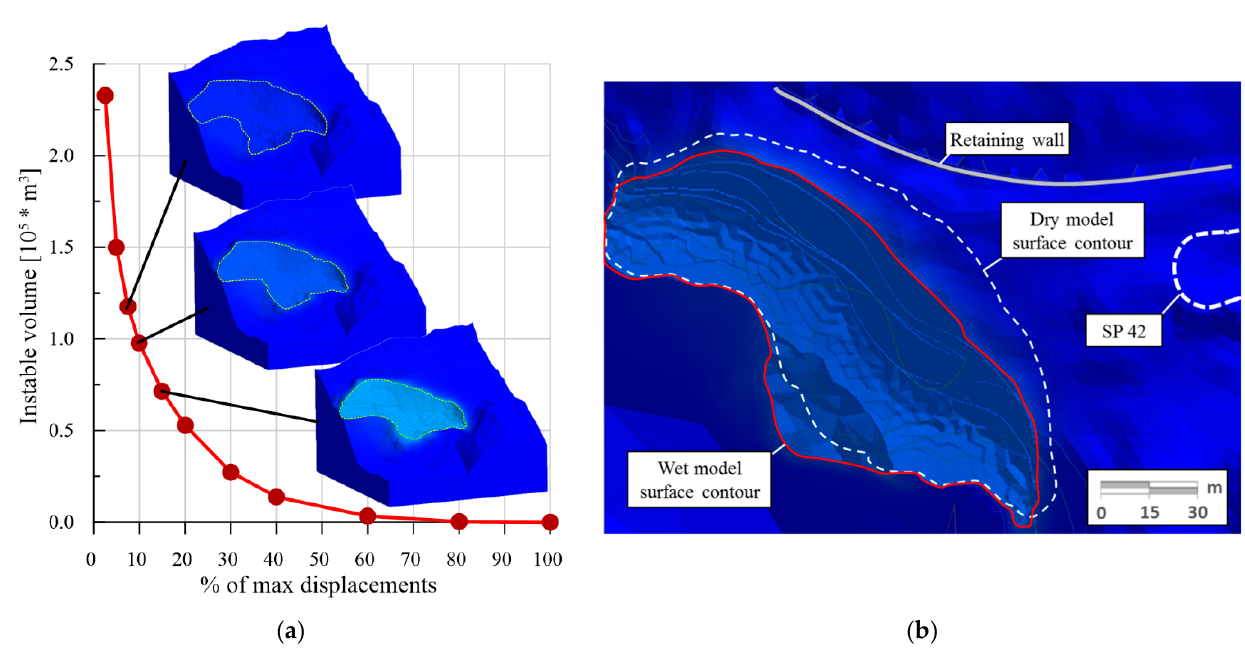
Figure 8. ( a ) Unstable volume in relation with the percentage of maximum displacements for the wet condition; ( b ) landslide sliding surface in wet model obtained removing the unstable mass. The external limit of unstable area in dry state is also overlapped for sake of comparison.